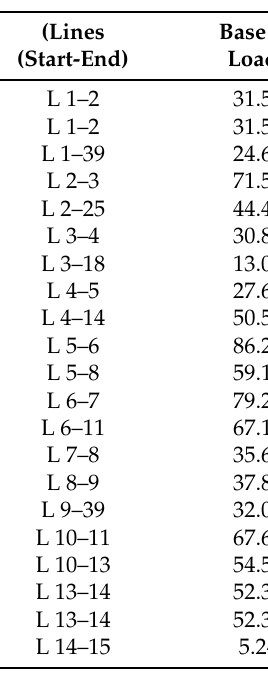
Table 13. Loading conditions of the lines for the IEEE 39-bus